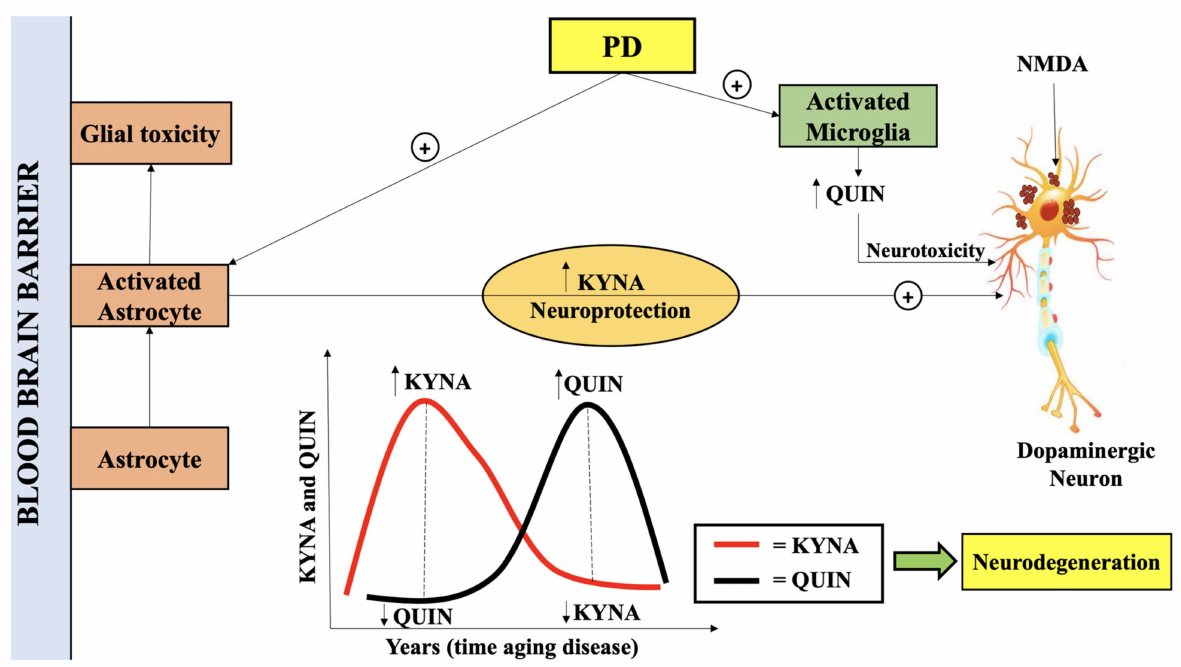
Figure 4. Neuroprotection mediated by KYNA against neurotoxic effects of QUIN, mediated by microglia and astrocyte activation. Legend: PD—Parkinson’s disease, NMDA—N-methyl-D-aspartate receptor, KYNA—kynurenic acid, QUIN— quinolinic acid, ↑ increased